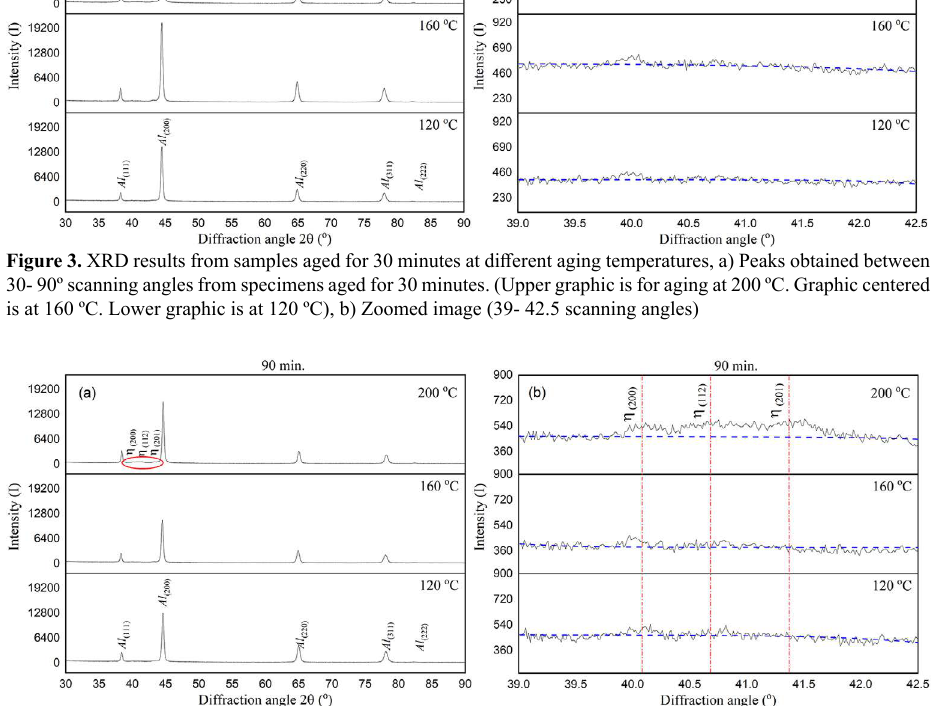
Figure 4. XRD results from samples aged for 90 minutes at different aging temperatures, a) Peaks obtained between 30- 90º scanning angles from specimens aged for 90 minutes, b) Zoomed image (39- 42.5 scanning angles)